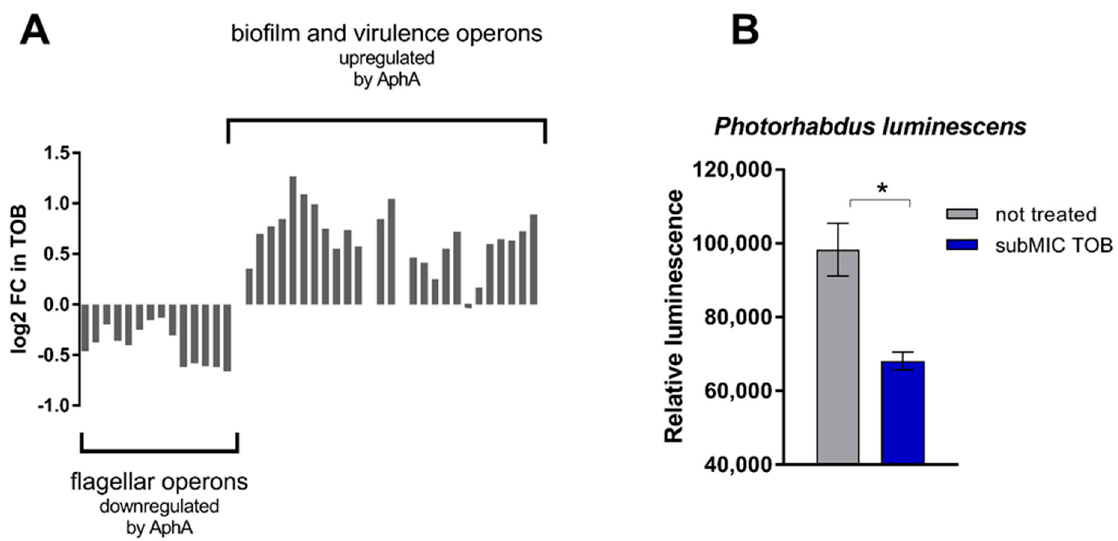
Figure 3. SubMIC TOB interferes with QS signalling. ( A ) Expression changes induced by subMIC TOB (2% MIC) of genes belonging to operons known to be regulated by AphA. ( B ) Effect of subMIC TOB (50% MIC) on QS-dependent luminescence of P. luminescens . Error bars indicate standard deviations. * p -value < 0.05 by Student’s t -test.